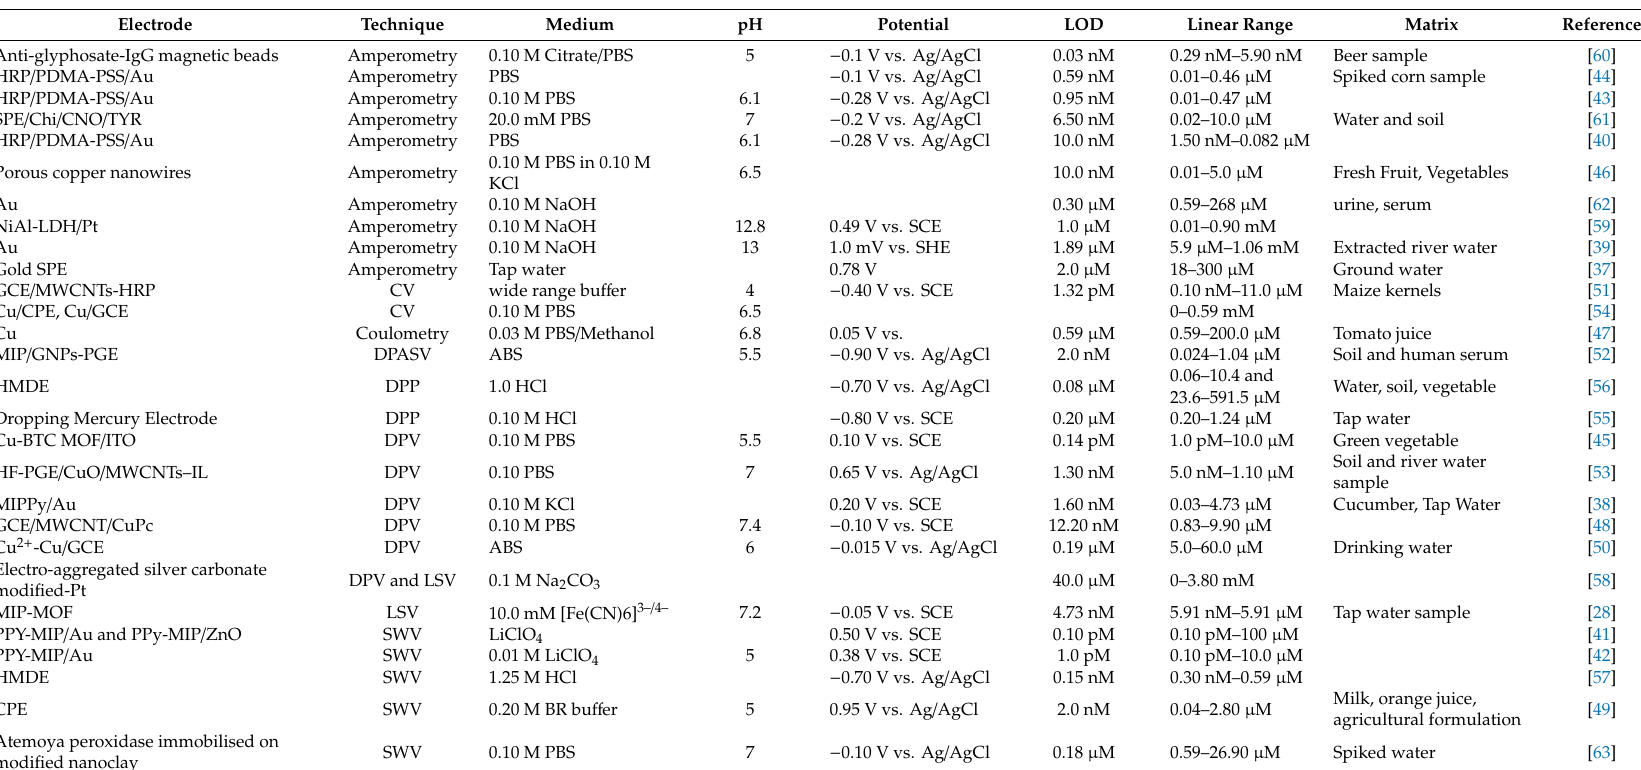
Table 1. Overview of reports on electrochemical methods, measurement conditions, analytical performance and sample matrix for the determination of